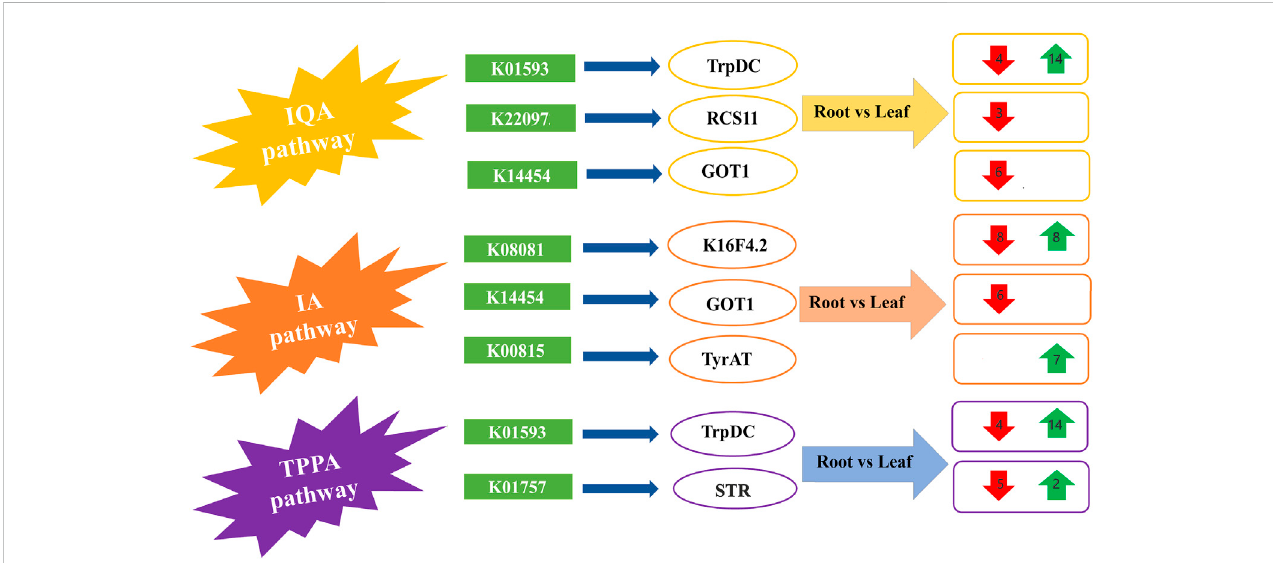
FIGURE 4 The schematic diagram for the proposed pathways of isoquinoline alkaloid biosynthesis (IQA), indole alkaloid biosynthesis (IA) and tropane, piperidine and pyridine alkaloid (TPPA) biosynthesis, along with the comparative expression of transcripts from leaf and root tissues of Veratrum mengtzeanum . The red and green arrows represent downregulated and upregulated transcripts in the respective pathways related to the major proteins coding